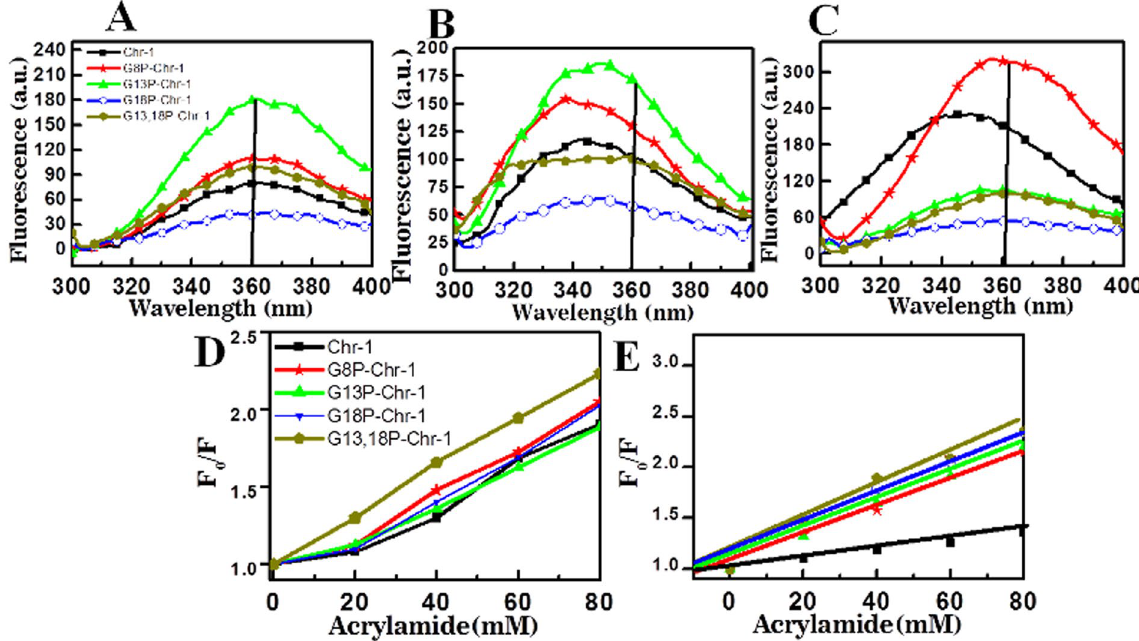
Figure 5. Intrinsic tryptophan fluorescence of Trp4 of Chr-1 and its analogs in different environments. ( A ) Shows the inherent fluorescence of all the peptides in Phosphate buffered saline (PBS) (pH-7.4). ( B ) Shows the blue shift of the peptides (3 µ M) when they were added to the PBS with subsequent addition of negatively charged PC/PG vesicles (165 µ M). ( C ) Shows the blue shift of the peptides (10 µ M) when they were added to the PBS with subsequent addition of zwitterionic PC/Chol vesicles (220 µ M). ( D and E ) Shows the Stern-Volmer plots to illustrate the effect of adding an aqueous acrylamide quencher to reveals the peptides interaction with PC/PG and PC/Chol vesicles respectively. Symbols as indicated inside the different